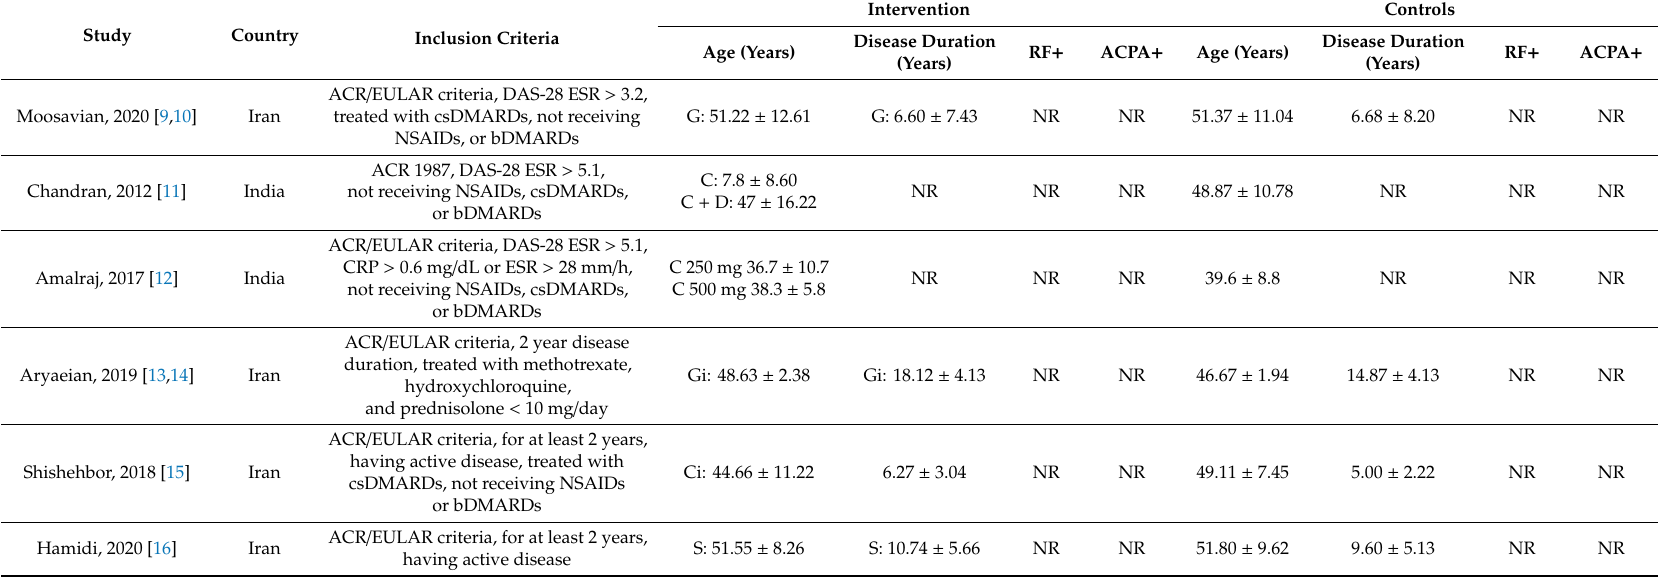
Table 1. Baseline characteristics of